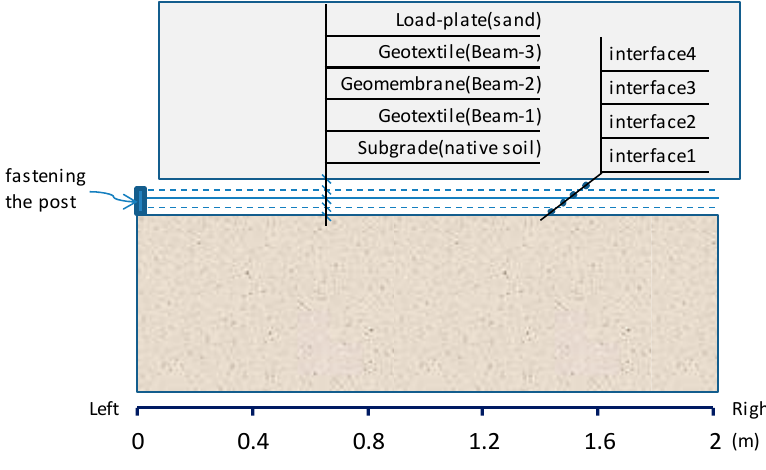
Figure 8. Composite liner system in direct shear test.